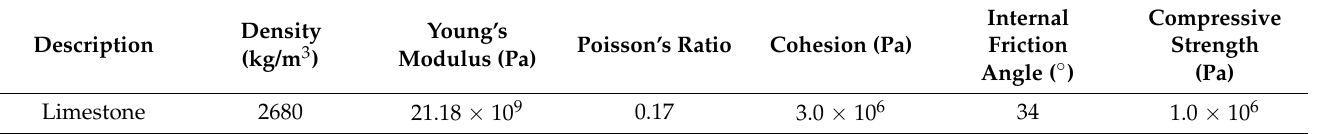
Table 3. Mechanical parameters of the foundation pit slope.